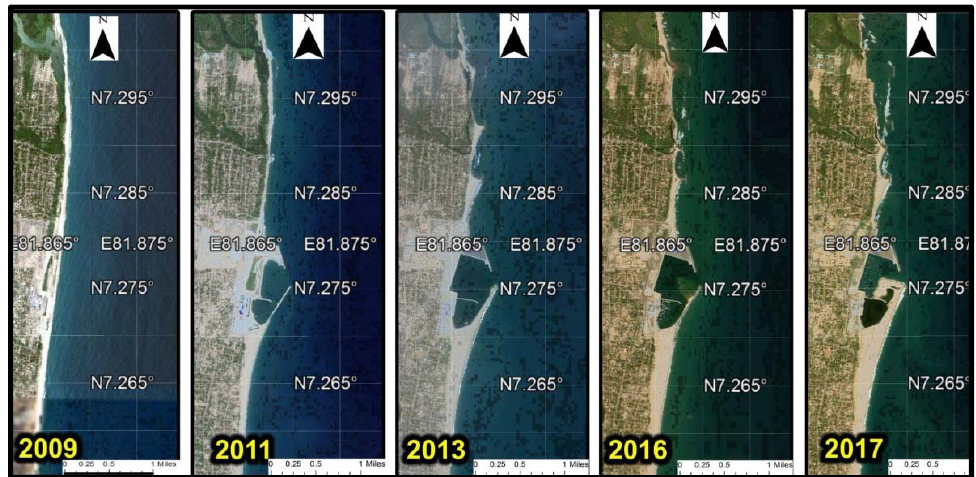
Figure 8. Morphological changes of the littoral zones of the east coast from 2009 to 2017. (Image pixel: 30 m × 30 m, positional accuracy: 39.7 m and RMSE: 0.4–171.6 m.). Note that the 2011 image is different from other images because the harbor construction work was in progress.